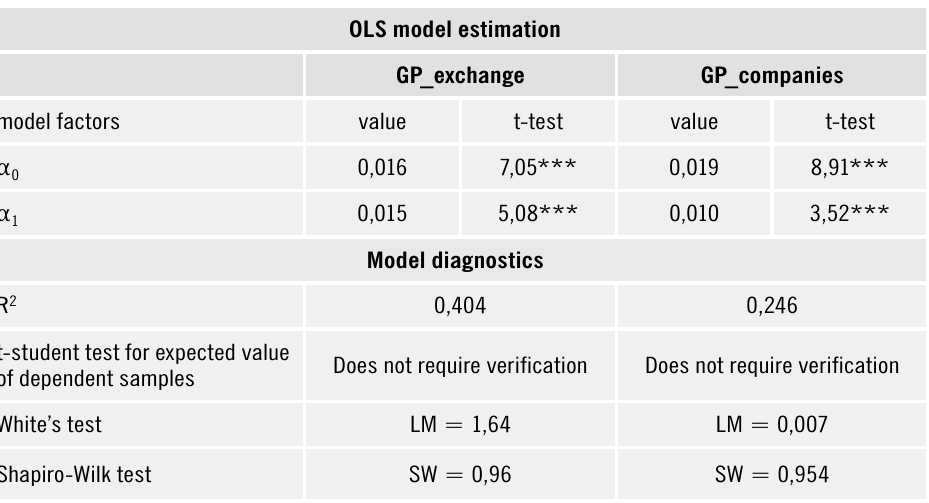
Table 4. Regression models for OF and GP _ exchange and GP _ companies OLS model estimation